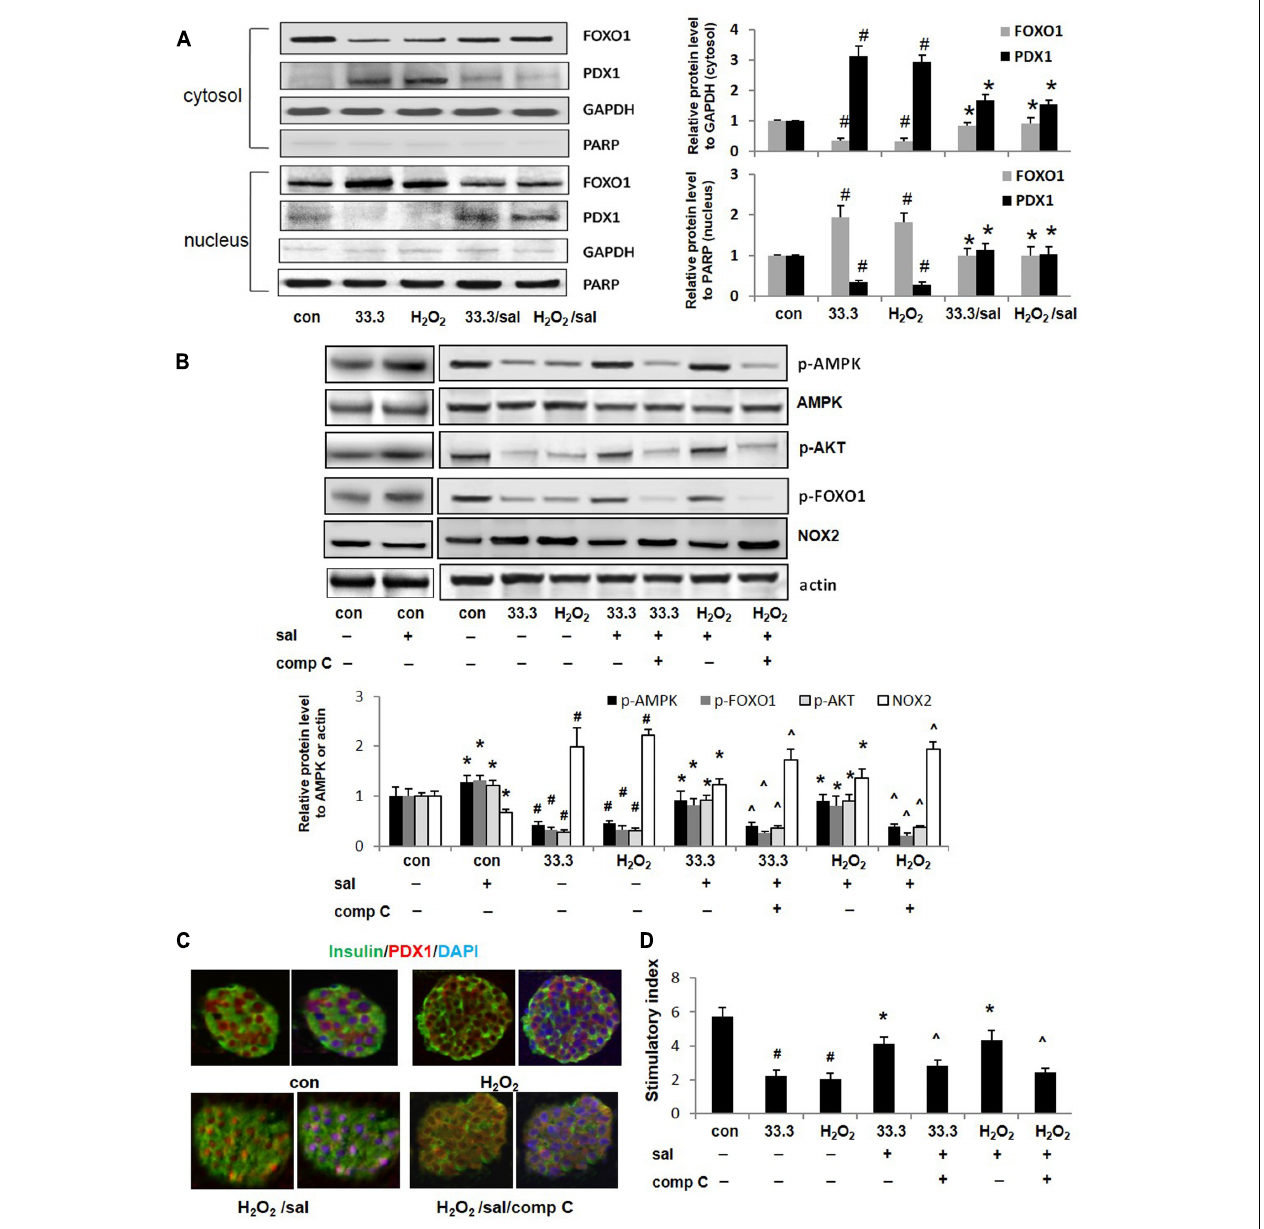
FIGURE 5 | Salidroside improved PDX1 nuclear localization and β -cell function depended on AMPK activation. (A) The cellular distributions of FOXO1 and PDX1 were detected by western blotting analysis in Min6 cells treated by high glucose or H 2 O 2 for 2 days. (B) Effects of compound C (10 µ M) on phosphorylations of AMPK, AKT, FOXO1, and expression of NOX2 in Min6 cells were examined by western blot analysis. The densitometry analyses of three independent experiments are shown. (C) Isolated mouse islets were exposed to H 2 O 2 with salidroside or compound C (comp C), DMSO as control for 12 h. Islets were triple-stained for PDX1 in red, insulin in green, and DAPI in blue to detect the PDX1 localization. (D) GSIS assay was performed in treated mouse islets with/without salidroside. Stimulatory index denotes the amount of stimulated divided by the amount of basal insulin secretion. Data are shown as mean ± SE from three independent experiments ( # p < 0.05 33.3 or H 2 O 2 to control, ∗ p < 0.05 salidroside to DMSO, and ˆ p < 0.05 Sal/comp C to